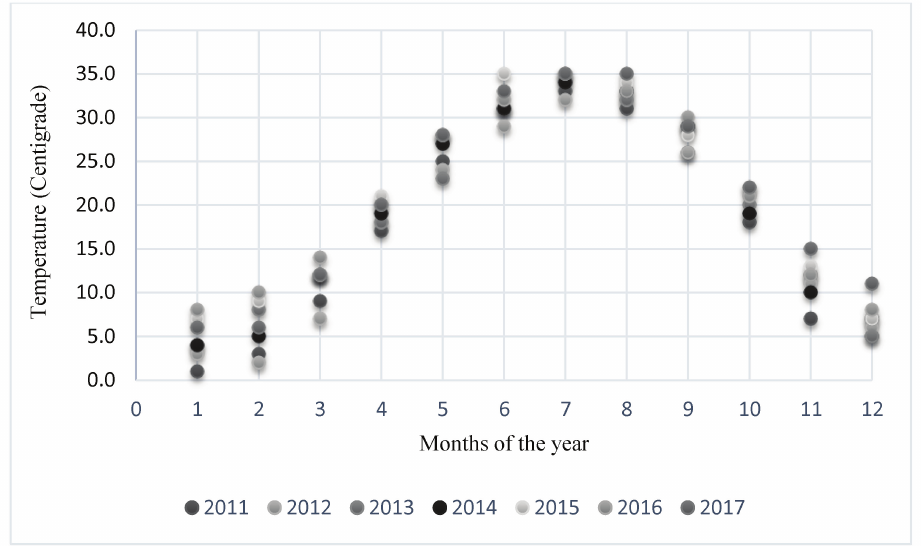
Figure 2. Average temperature in each month in the study